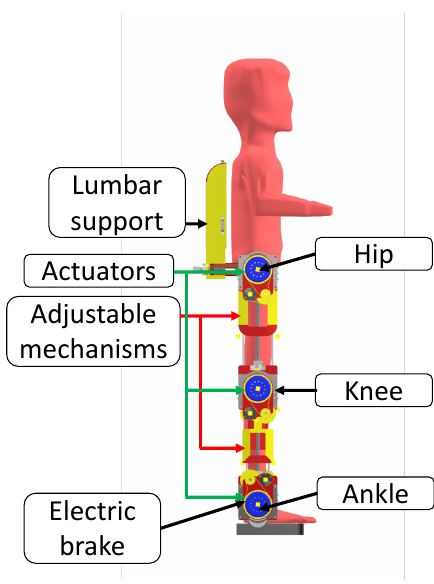
Figure 2. Exoskeleton main